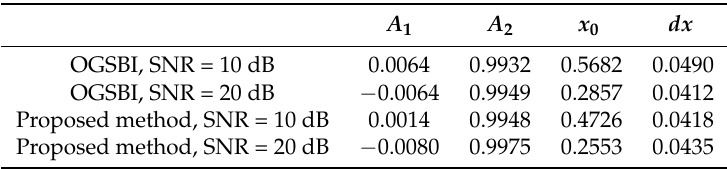
Table 4. Fitting